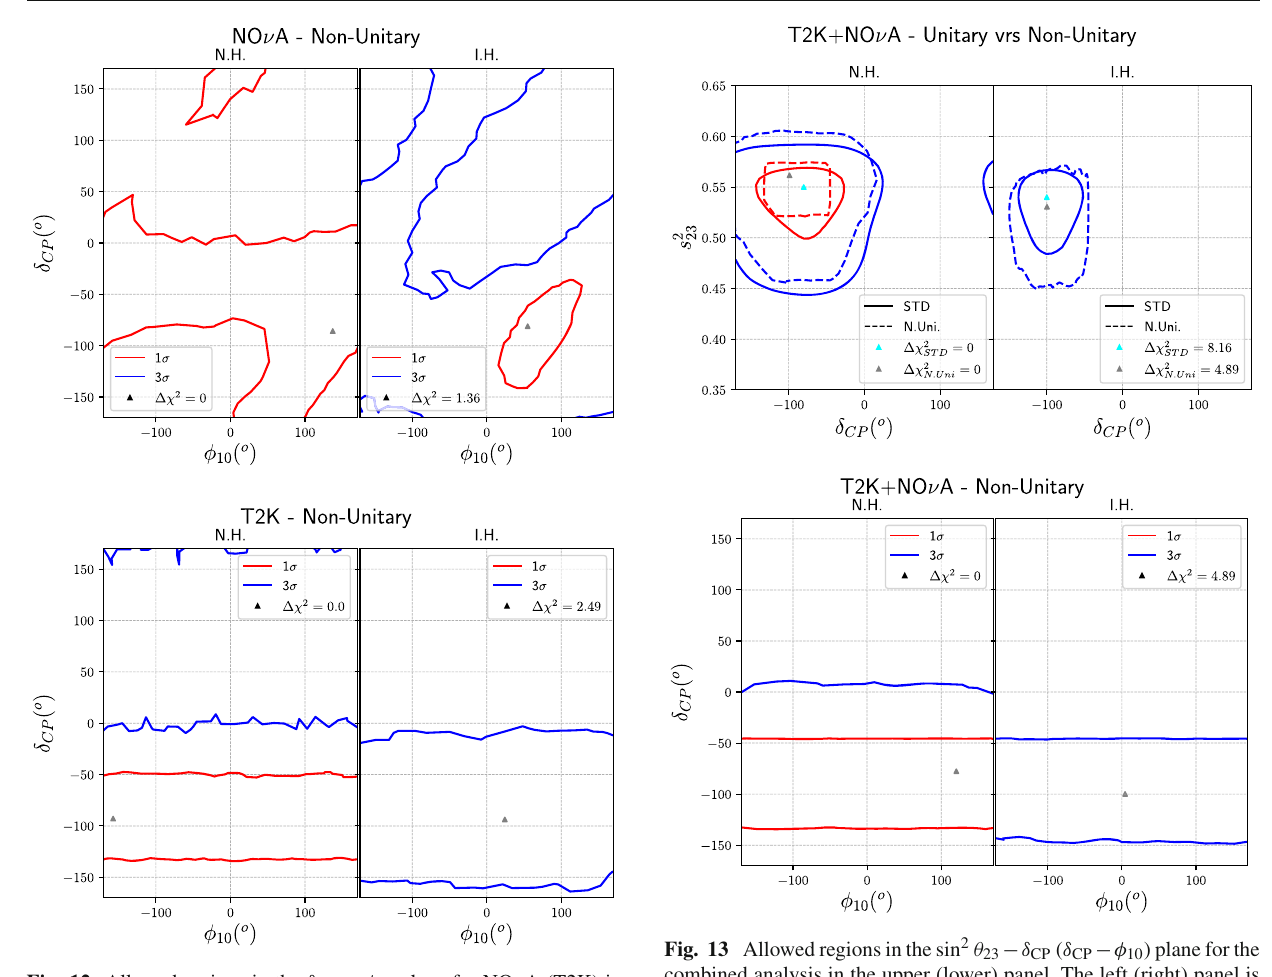
Fig. 12 Allowed regions in the δ CP − φ 10 plane for NO ν A (T2K) in the upper (lower) panel. The left (right) panel is for NH (IH). The mini- mum χ 2 for NO ν A (T2K) in the case of unitary and non-unitary mixing are 47.92 and 44.38 (123.71 and 121.37), respectively. The parame- ter values at the best-fit point have been mentioned in Table 1 (2) for NO ν A (T2K). These results are for 2019 data